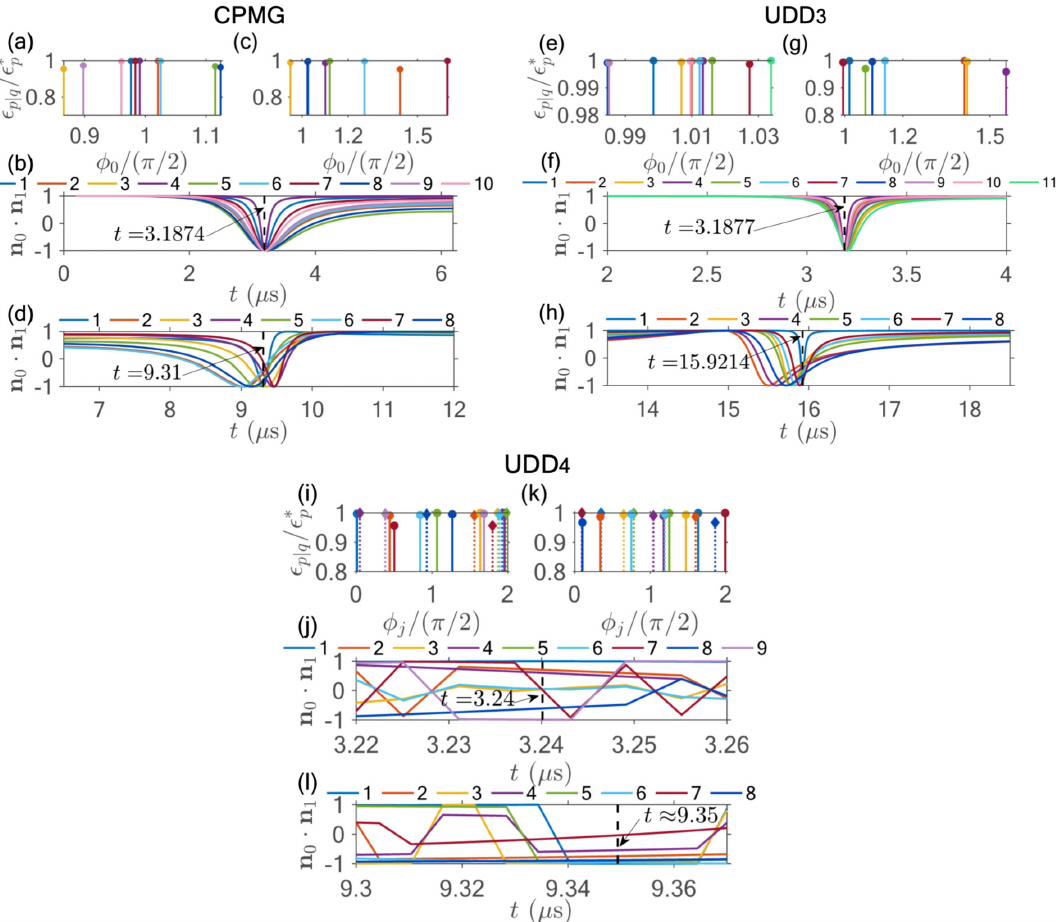
2 = 9 ) versus accumulated rotation angle for CPMG (a) [ ð N (cid:3) ; k Þ ¼ FIG. 6. Nuclear one-tangles (scaled by the maximum value ϵ (cid:3) p ¼ ð 56 ; 1 Þ ] and (c) [ ð N (cid:3) ; k Þ ¼ ð 8 ; 2 Þ ], UDD 3 (e) [ ð N (cid:3) ; k Þ ¼ ð 487 ; 1 Þ ] and (g) [ ð N (cid:3) ; k Þ ¼ ð 93 ; 3 Þ ], and UDD 4 (i) [ ð N (cid:3) ; k Þ ¼ ð 252 ; 1 Þ ] and (k) [ ð N (cid:3) ; k Þ ¼ ð 41 ; 2 Þ ]. The different lines correspond to nuclear spins that we label with an integer index j . The dot product of nuclear rotation axes close to k ¼ 1 CPMG resonance (b), k ¼ 2 CPMG resonance (d), k ¼ 1 UDD 3 resonance (f), k ¼ 3 UDD 3 resonance (h), k ¼ 1 UDD 4 resonance (j), and k ¼ 2 UDD 4 resonance (l). The vertical lines in the dot product panels denote the common time of the basic unit used to evaluate the corresponding one-tangles and is the resonance of nuclear spin “ 1. ” In (i) and (k), the lines with circles correspond to ϕ 0 and the lines with diamonds to ϕ 1 . The nuclear spins for each set ð N (cid:3) ; k Þ of each sequence are different and are provided in Tables II (CPMG), III (UDD 3 ), and IV (UDD 4 ) in Appendix